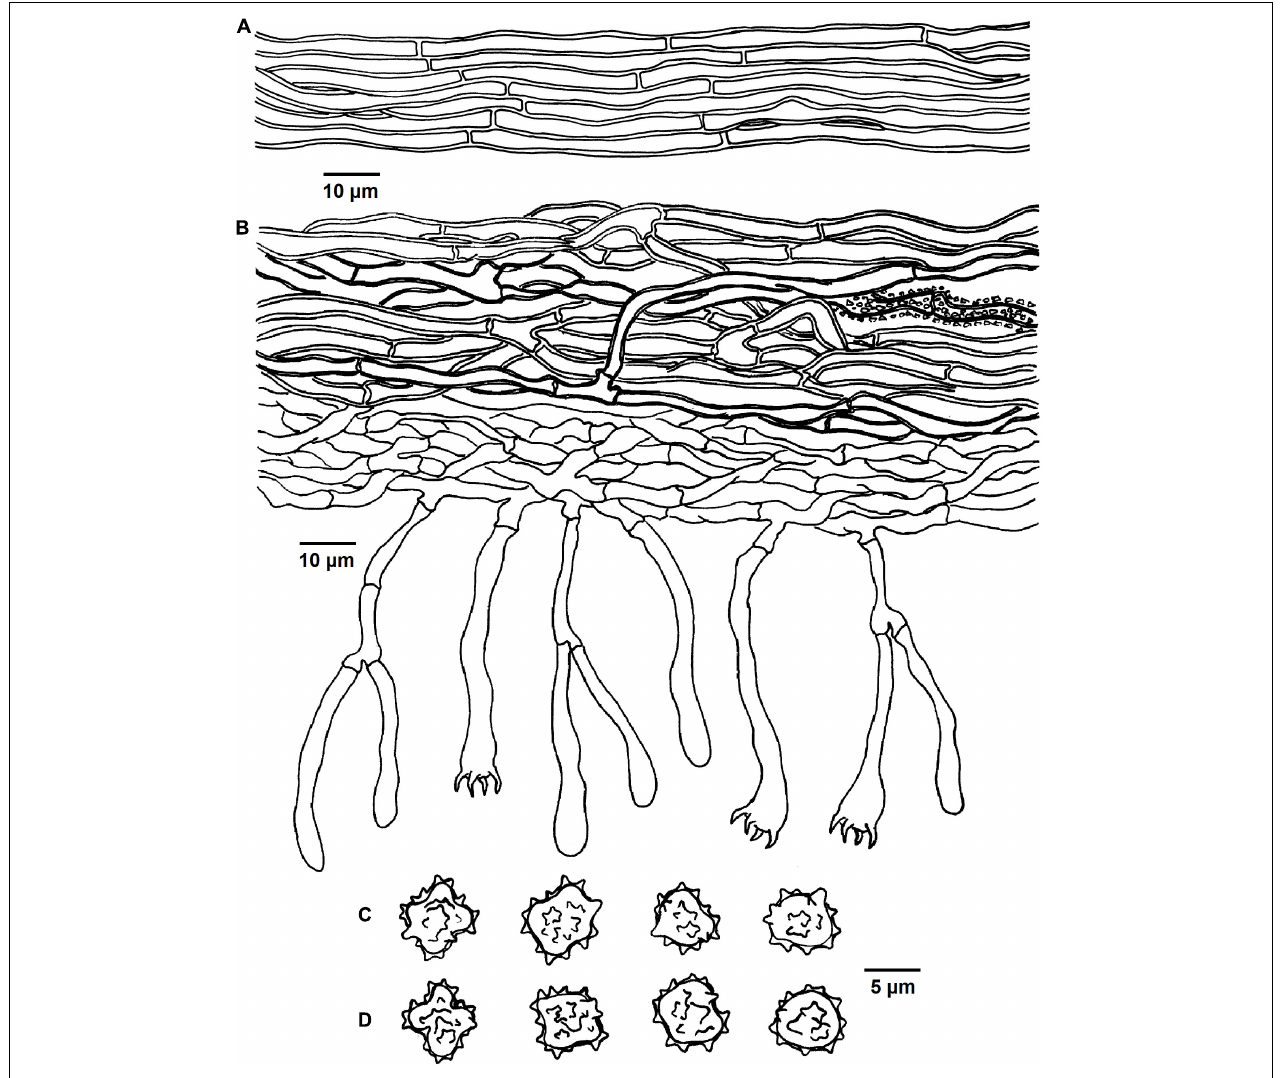
FIGURE 9 | Microscopic structures of Tomentella verruculata (drawn from Yuan 12684). (A) Hyphae from a rhizomorph. (B) A section through basidiocarp. (C) Basidiospores in lateral face. (D) Basidiospores in frontal